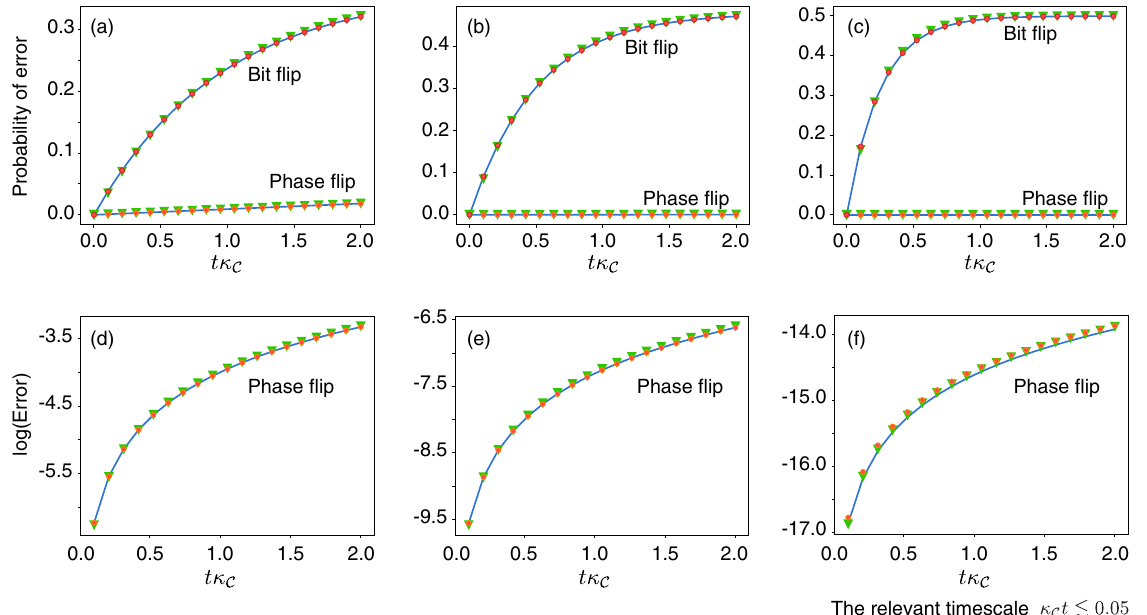
FIG. 10. Comparison of dissipation predicted by (i) the effective two-level master equation (solid line), (ii) the common bosonic master equation (dots), and (iii) the master equation of a PCO coupled with a finite-linewidth oscillator to emulate a general non- Markovian bath (triangles). In all the cases, K is fixed and P is varied so that β ¼ 1 , β ¼ For the dots, κ C ¼ K= 100 , and for the triangles, g ¼ 0 . 05 K and κ of a bit-flip error is estimated by initializing the PCO to the state j C þ β i and estimating h C − β j ˆ ρ is estimated by initializing the PCO to the state jþi and estimating h − j ˆ ρ − i(cid:2) corresponding to (a), (b), and (c), phase error log ½h − j ˆ ρ PCO j